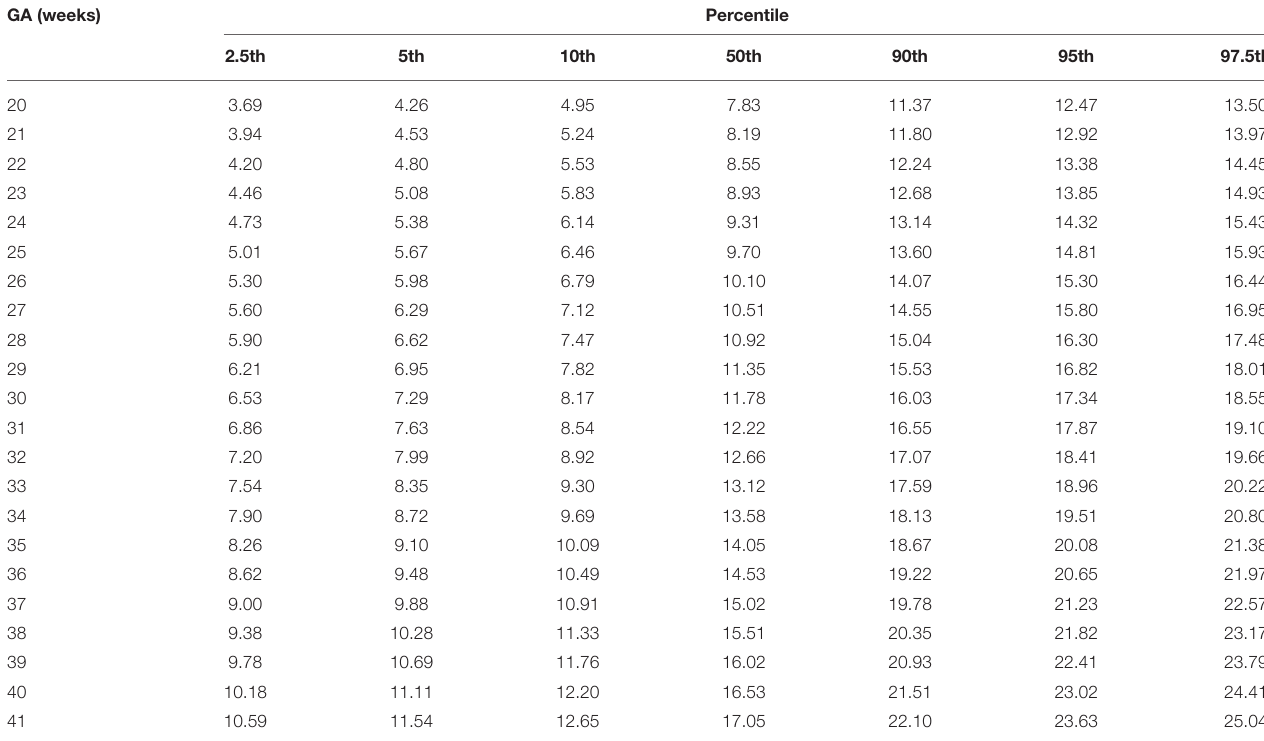
TABLE 3 | Longitudinal reference percentiles of fetal ascending aorta mean longitudinal strain (MLS, %). GA (weeks)